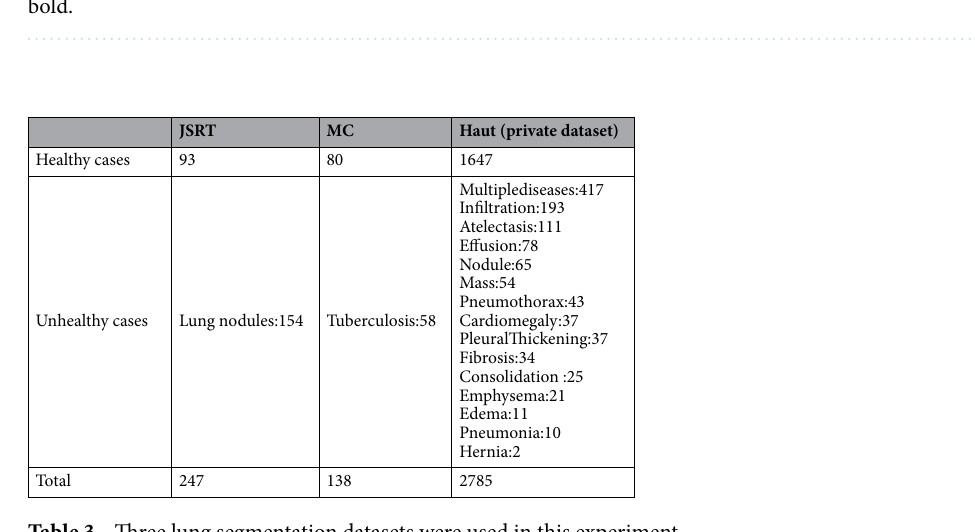
Table 2. Lung segmentation results on the MC dataset (mean ± standard deviation). Significant values are in bold.